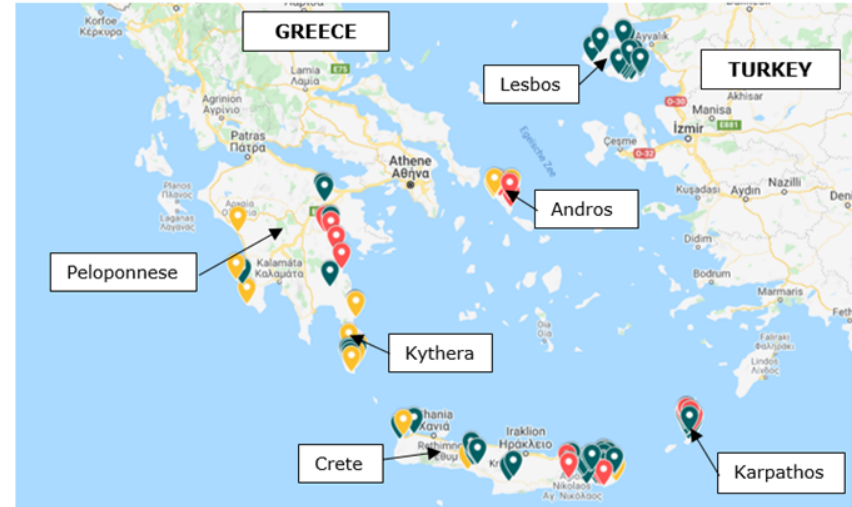
Figure 1. Overview of the collecting sites of the leek CWR collecting mission 2009. The blue, yellow and red dots indicate Allium ampeloprasum, A. commutatum and A. bourgeaui , respectively. For collecting site details: https://www.wur.nl/en/Research-Result